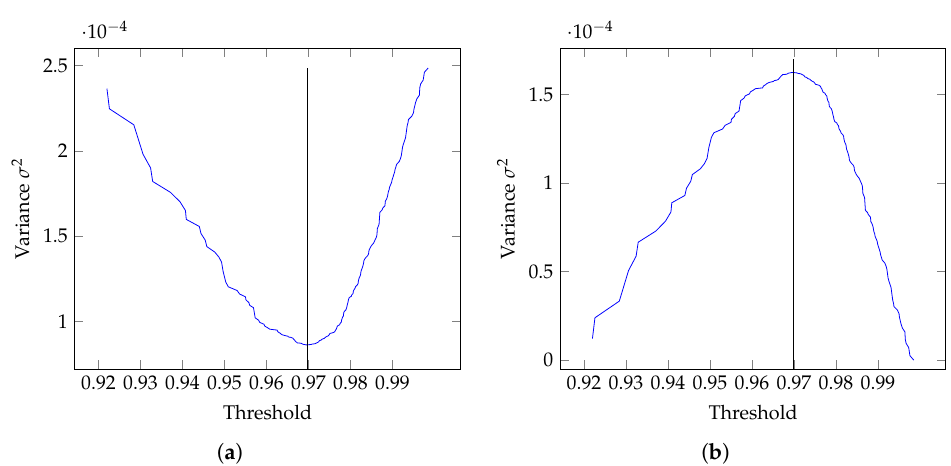
Figure 5. WCV and BCV histograms for the β band (13–30 Hz) for the IM right-hand. The optimum threshold value is T = 0.9698, indicating the minimum WCV value and the maximum BCV value. ( a ) Within-Class Variance (WCV) with the minimum value of 8.61 × 10 − 05 at threshold position T = 0.9698. ( b ) Between-Class Variance (BCV) with the maximum value of 1.62 × 10 − 04 at threshold position T = 0.9698.